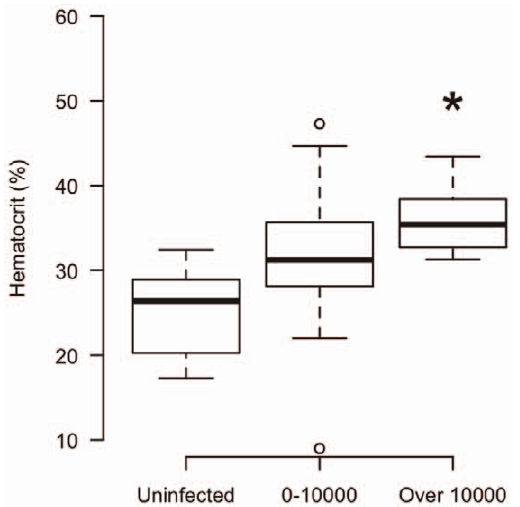
Figure 4. Hematocrit in yellow-legged frogs grouped by intensity of infection with Batrachochytriumdendrobatidis . The group of frogs with over 10,000 zoospore equivalents had significantly different hematocrit percentages compared with the group that was uninfected (Tukey HSD, P =0.02).